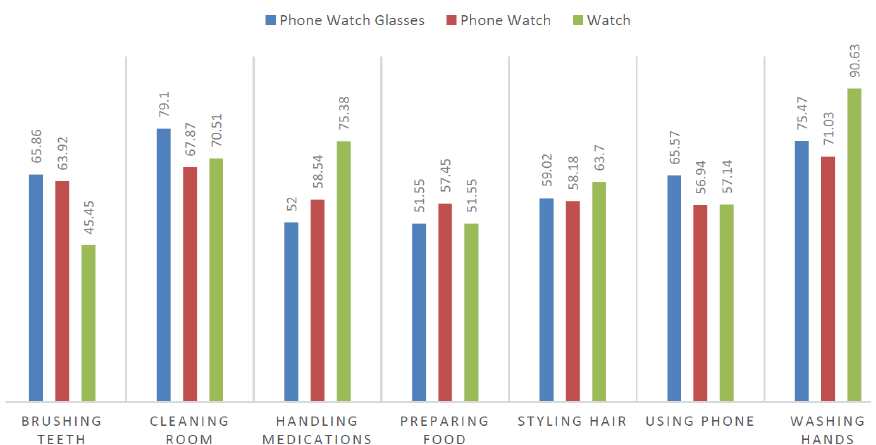
Figure 5. Performance comparison in terms of device combinations. The results are shown in terms of F1